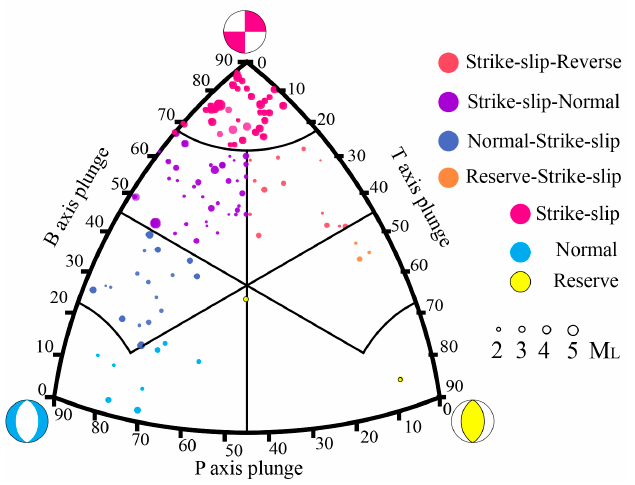
Figure 5. Types of focal mechanism solutions of the Yangbi earthquake sequence.